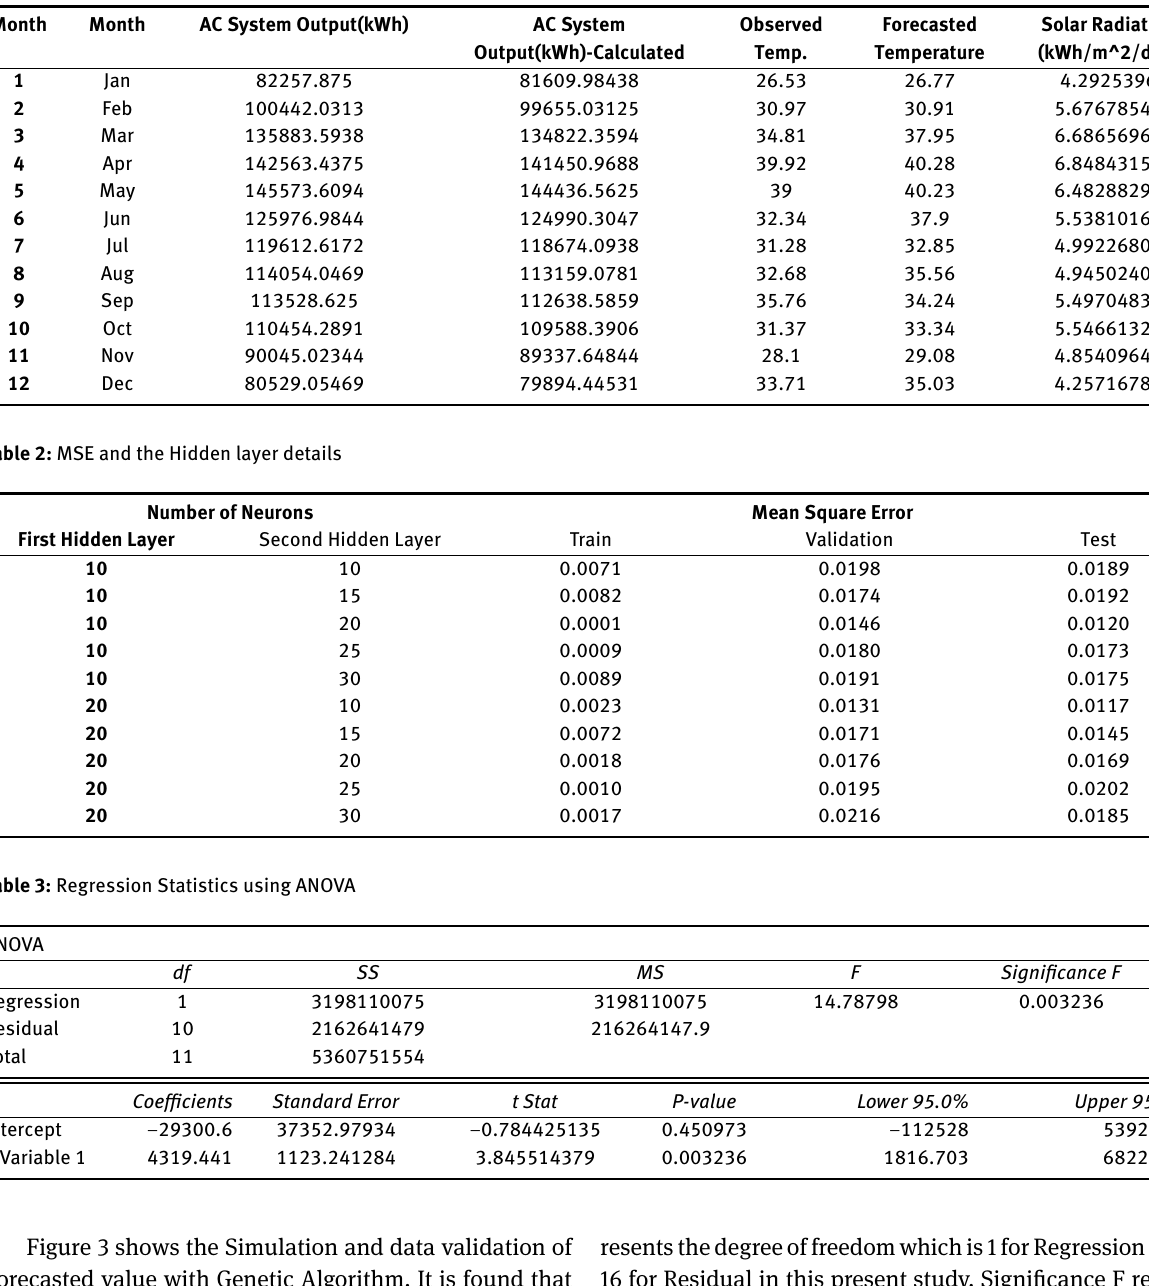
Table 1: Observed & Calculated value of Environmental Temperature and Solar PV Output